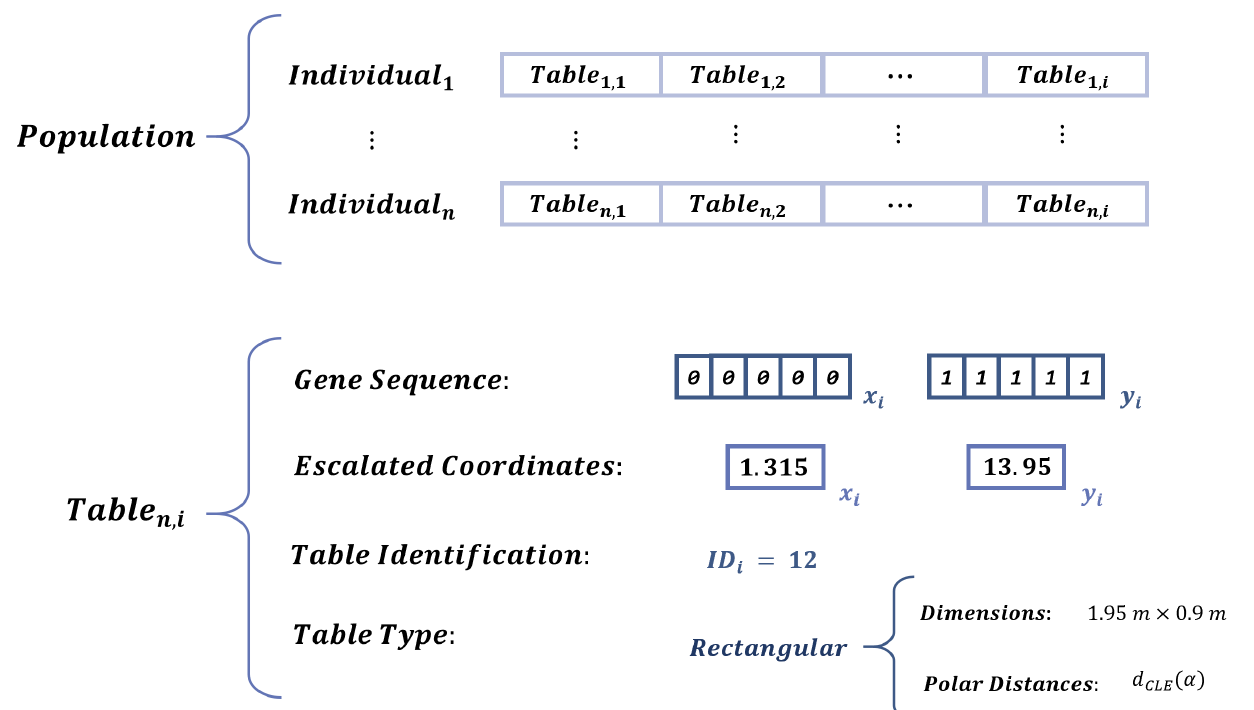
Figure 3. Table Codification implemented for the TLP. Each individual of the population carries a set of tables. Each table contains all the required information, including the gene sequence, the escalated coordinates with respect to the scenario limits, a unique identification number and a particularisation of the geometry and distances of the CLE. The proposed codification is compatible with multiple table geometries, and is independent of the selected scenario of